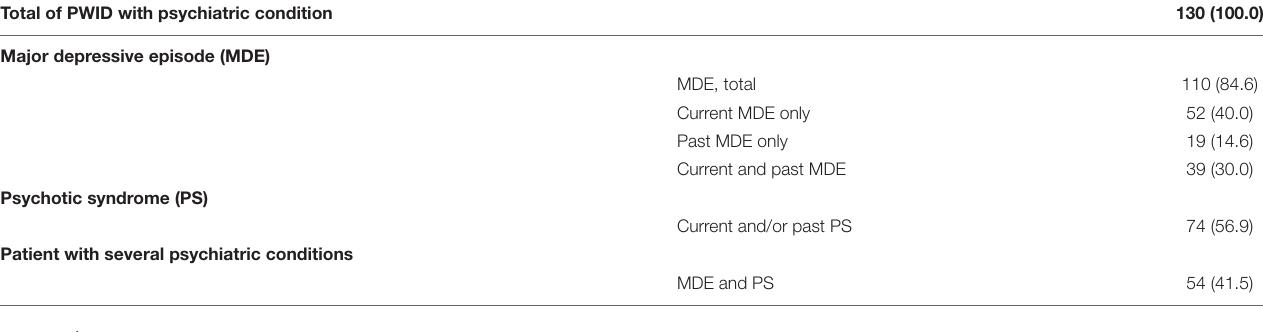
TABLE 1 | Psychiatric diagnoses assessed by the MINI test, n (%).